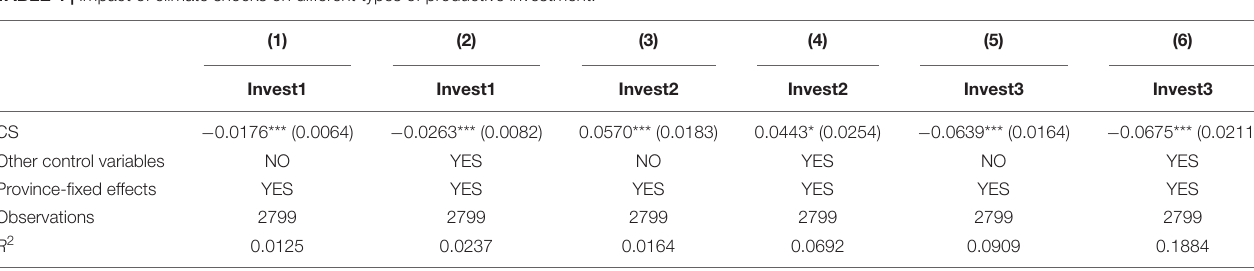
TABLE 4 | Impact of climate shocks on different types of productive investment.